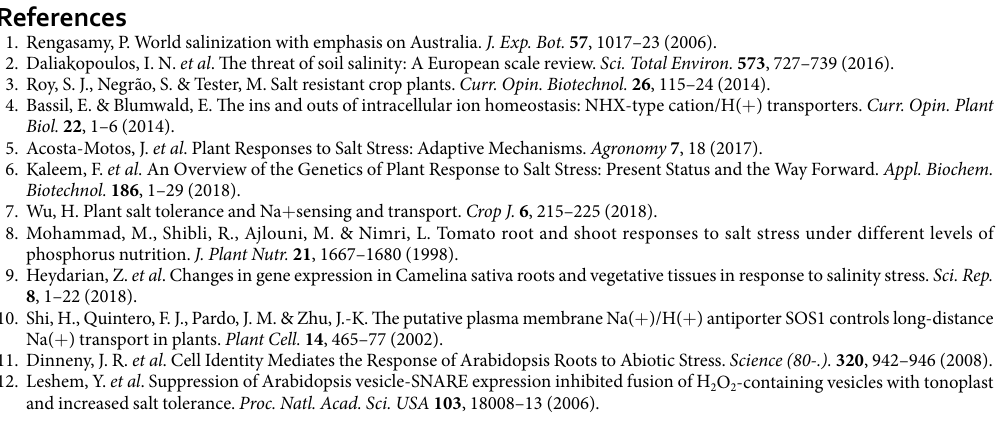
H 2 O 2 was detected by 3,3 ′ -diaminobenzidine (DAB) stain- ing, as previously described 56 . Salt stressed Seedlings with and without 20 μ m diphenyleneiodonium (DPI) 13 were treated with DAB Staining buffer for 60 min and the reaction was stopped by adding Ethanol: glycerol: acetic acid (3:1:1). Images were captured using trinocular and inverted microscopes mentioned above. H 2 O 2 was also detected by 2 ′ ,7 ′ - dichlorodihydrofluorescein diacetate (DCFDA) as in 57 . Salt treated plants were washed and treated with 50- μ M (DCFDA) in water. After 30 min of incubation, the ROS-specific fluorescence was detected using a confocal microscope LSM710 (Zeiss) using Ex/Em 488/525 nm. Statistical and fluorescence analysis of images.